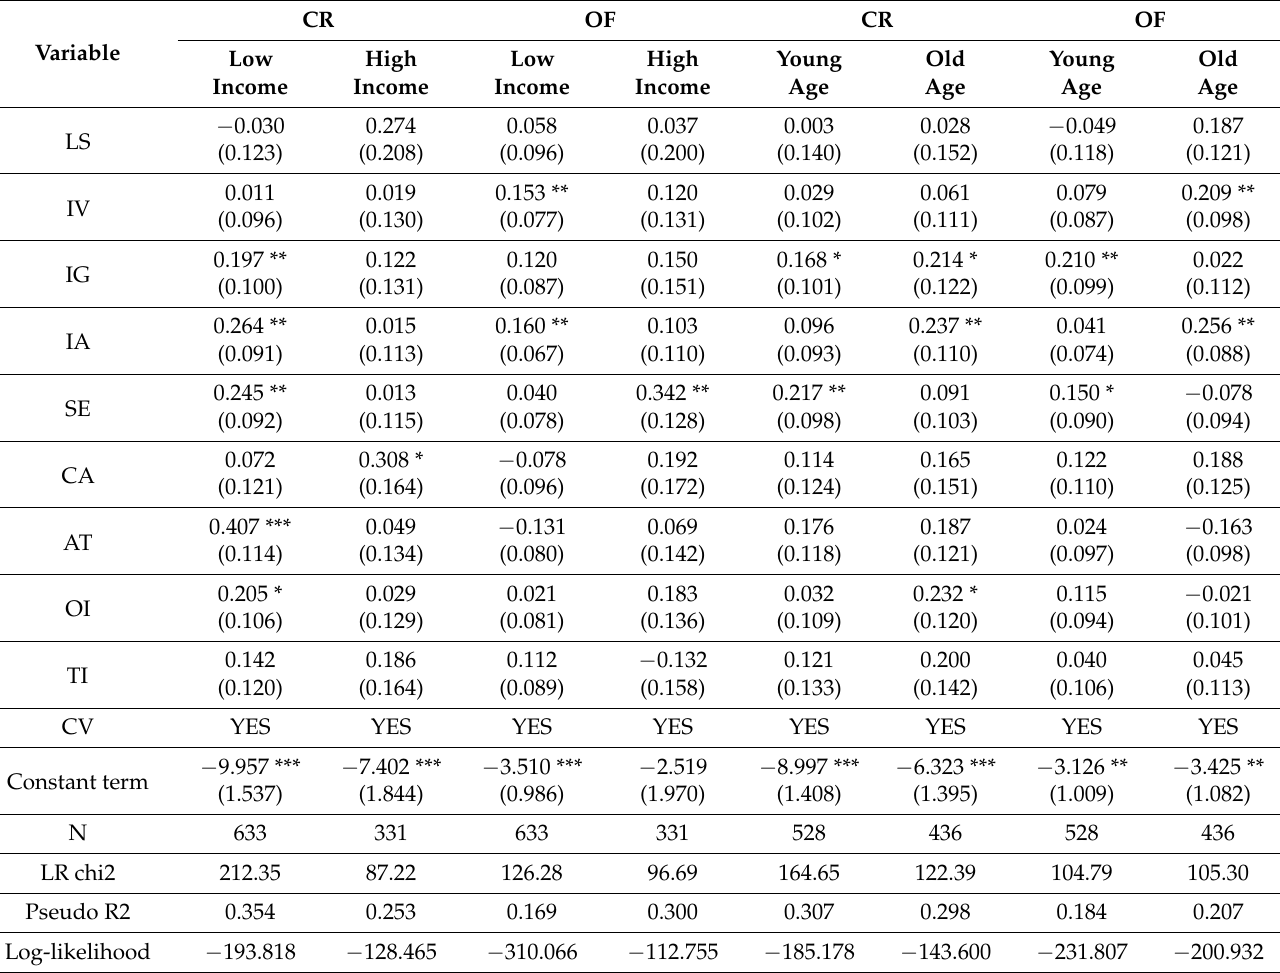
Table 5. Heterogeneity